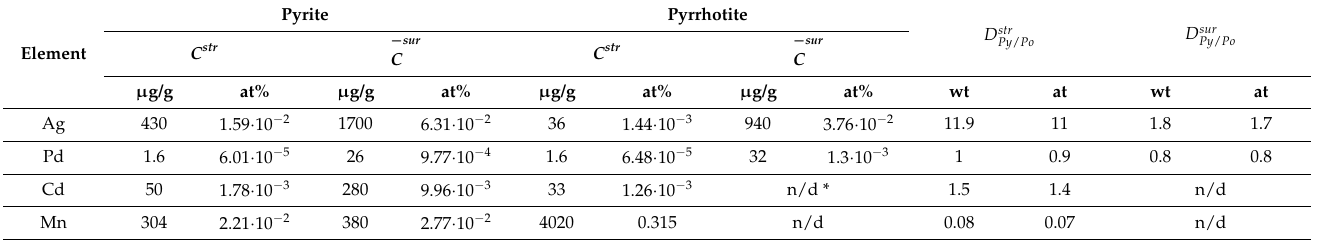
Table 3. Element contents in the volume of crystal and in near ‐ surface regions (within ~20 μ m) of pyrite and pyrrhotite crystals from LA ‐ ICP ‐ MS data, and volume and surficial distribution coeffi ‐ cients.